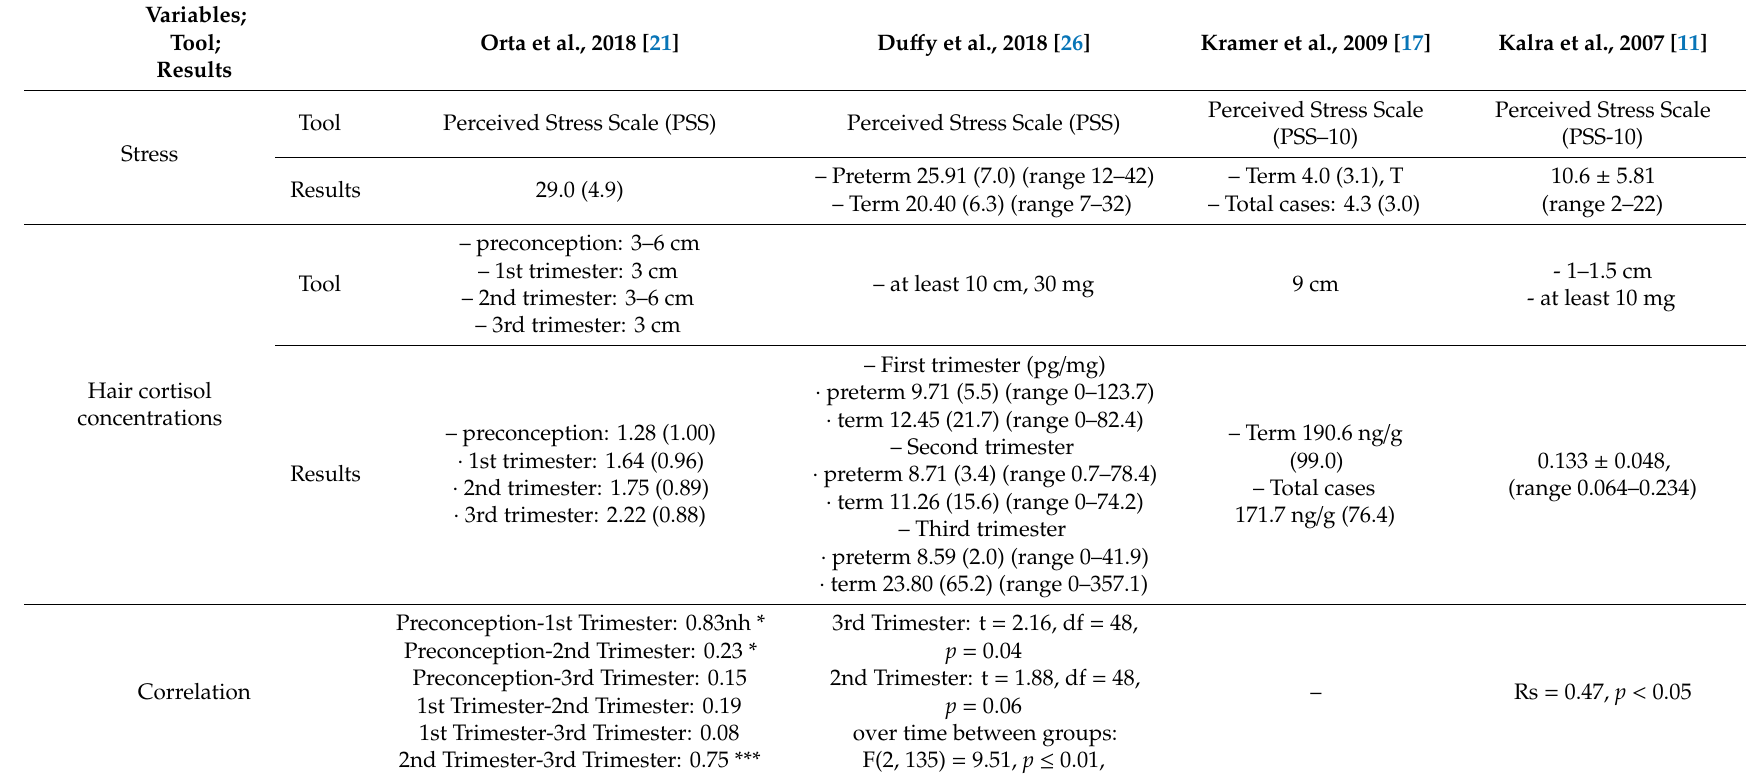
Table 2. Comparison of perceived stress and hair cortisol